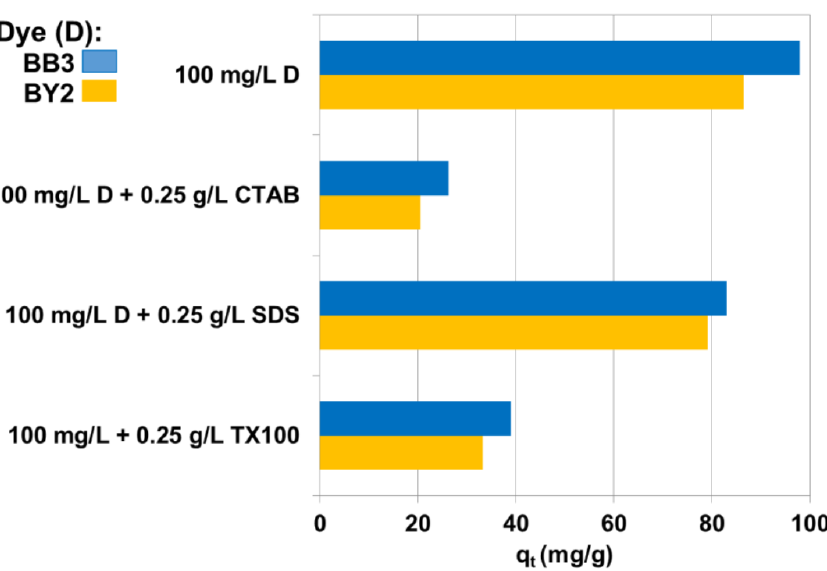
Figure 7. Impact of anionic (SDS), cationic (CTAB) and non-ionic (TX100) surfactants on dyes uptake by C/SiO 2